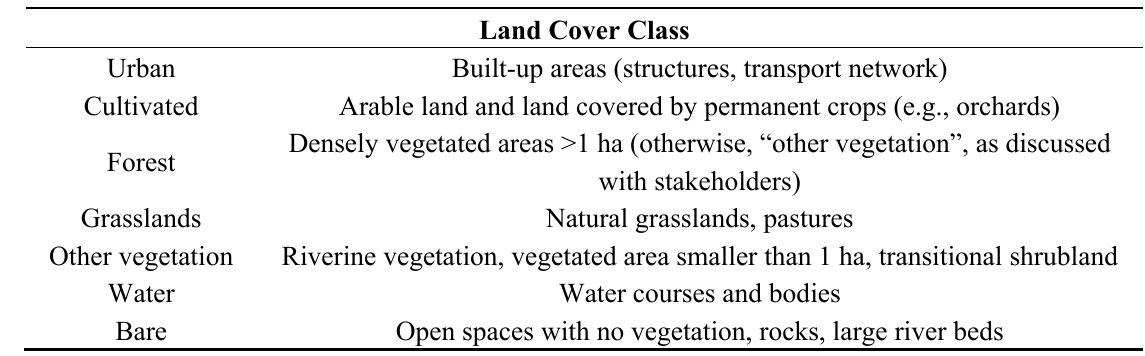
Table 2. Land cover class definitions.